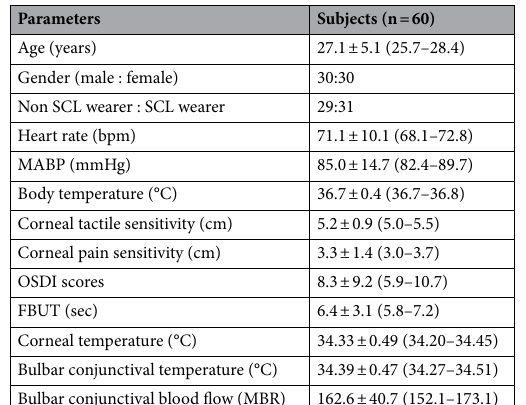
Table 1. Demographic data. The data are presented as the average ± deviation (95% confidence interval). SCL soft contact lens; MABP mean arterial blood pressure; OSDI Ocular surface disease index; FBUT fluorescein tear break-up time; MADE, mask-associated dry